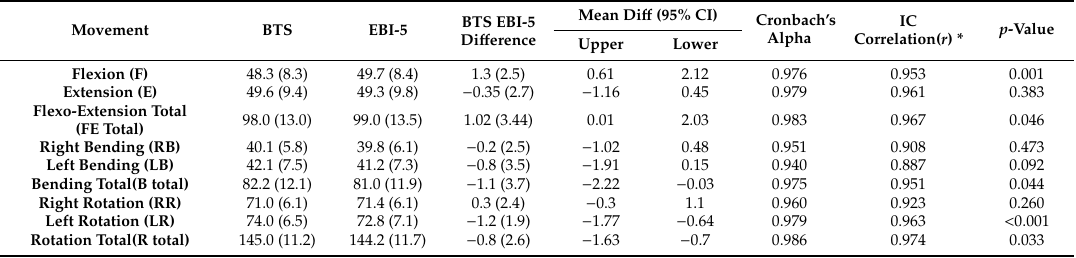
Table 2. Statistical results of the measures from the BTS (Bioengineering Technology and System) and EBI-5 systems.